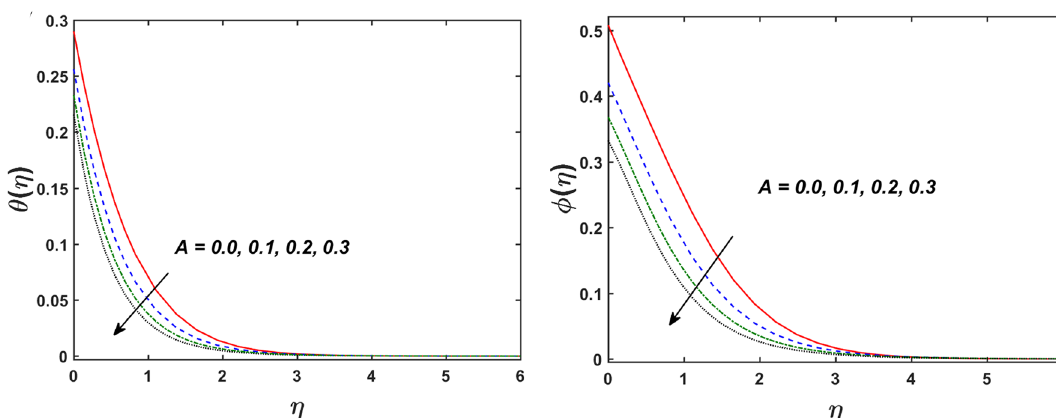
Figure 7. Variation in θ(η) and φ(η) for A